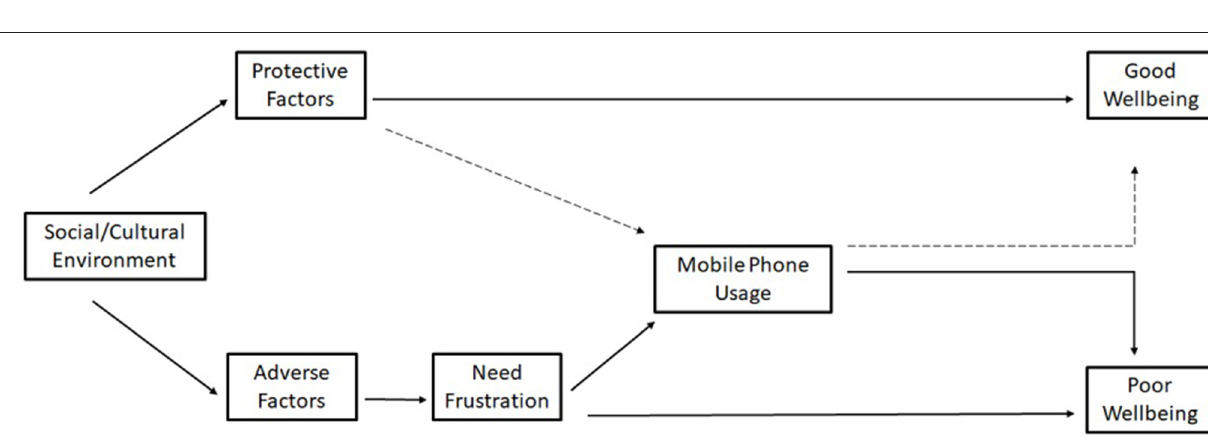
FIGURE 2 | Research application of BPNT